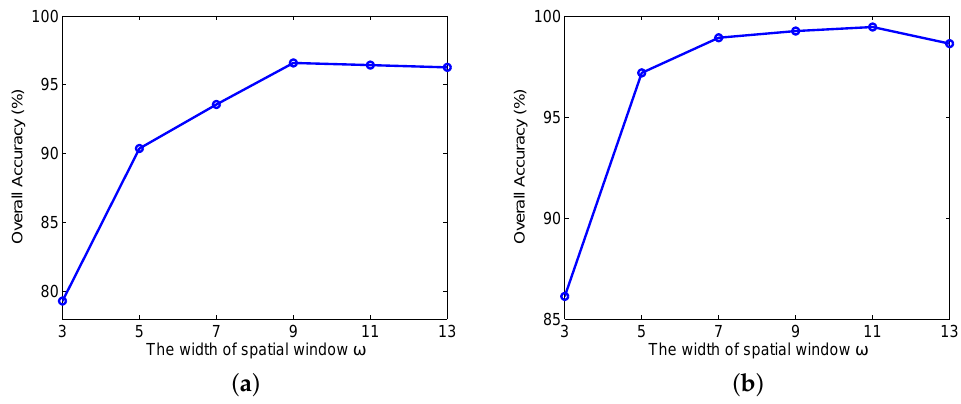
Figure 9. OA versus the width of the input feature window ω : ( a ) 5% training samples; and ( b ) 15% training samples.